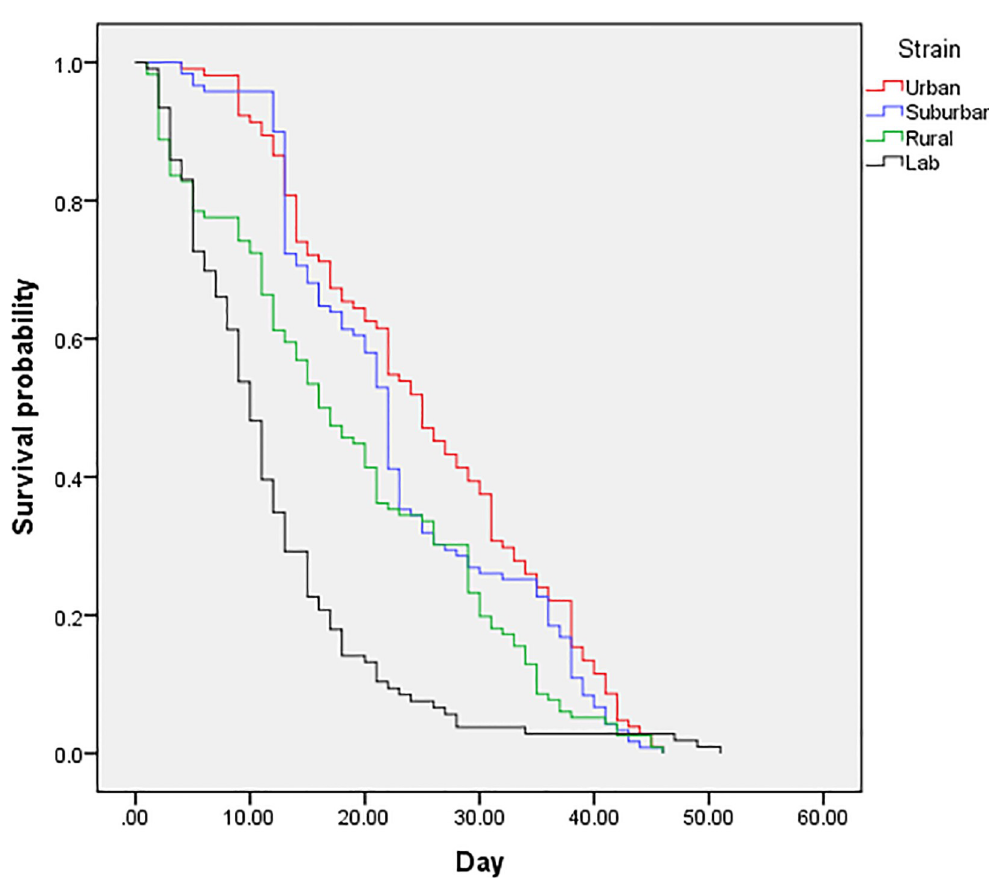
Fig 3. Cumulative survival probability of Aedes albopictus females from four different